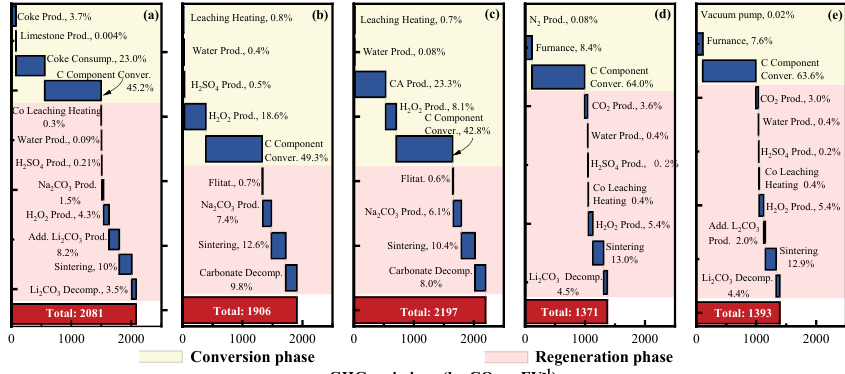
Figure 8. Contribution analysis of the GHG emissions in the conversion and regeneration phase for the five different recycling methods. ( a ) UHT method, ( b ) HM-SA, ( c ) HM-CA, ( d ) RR-N 2 , and ( e ) RR-Vac. The percentage labeling indicates the proportion of the GHG emission resulting from the manufacture of the materials or active electrode material processing needed for the recycling 1FU in the conversion and regeneration phase. The red bar indicates the total GHG emissions of the conversion and regeneration phase for the five different recycling methods.